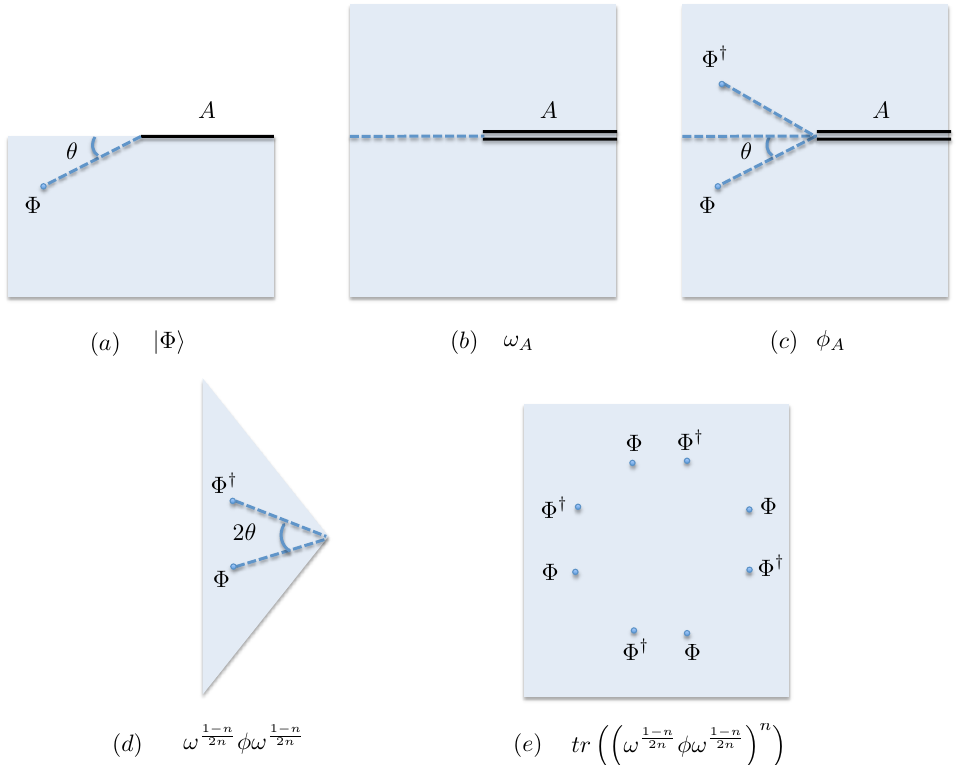
Figure 1 . The Euclidean path integrals that prepare (a) excited state matrix on region A , (c) the density matrix of A in the excited state. (d) The operator ! 1 (cid:0) n 2 n (cid:30)! 1 (cid:0) n 2 n corresponds to a path-integral on a wedge of angular size 2 (cid:25)=n . (e) The correlator that appears in the de(cid:12)nition of the sandwiched R(cid:19)enyi